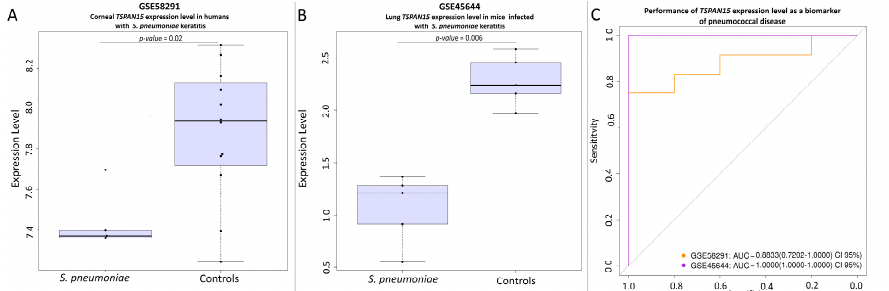
Figure 5. ( A ) Differential expression level of the TSPAN15 gene between corneal tissue from corpses and corneal tissue from S. pneumoniae keratitis patients in the study GSE58291. ( B ) Differential lung expression level of TSPAN15 gene between healthy mice and S. pneumoniae infected mice in the study GSE45644. ( C ) ROC evaluating the potential of the gene TSPAN15 as a biomarker in the studies GSE58291, and GSE45644.